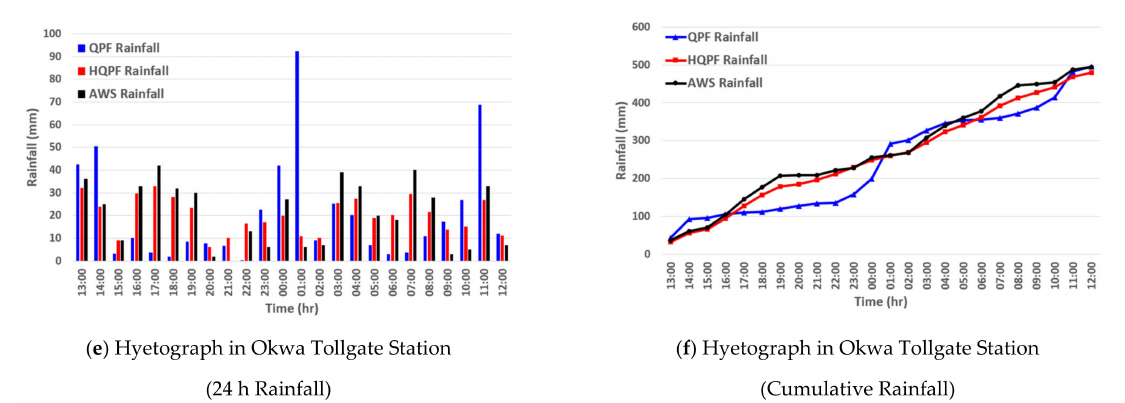
Figure 8. Precipitation Forecast at Nearby Precipitation Observation Stations. ( a ) Hyetograph of Gungchon Station, ( b ) 24-hour cumulative rainfall of Gungchon Station, ( c ) Hyetograph of Samjuk Elementary School Station, ( d ) 24-h cumulative rainfall of Samjuk Elementary School Station, ( e ) Hyetograph of Okwa Tollgate, and ( f ) 24-h cumulative rainfall of Okwa Tollgate. In each graph, black means AWS Rainfall, blue means QPF, and red means HQPF.